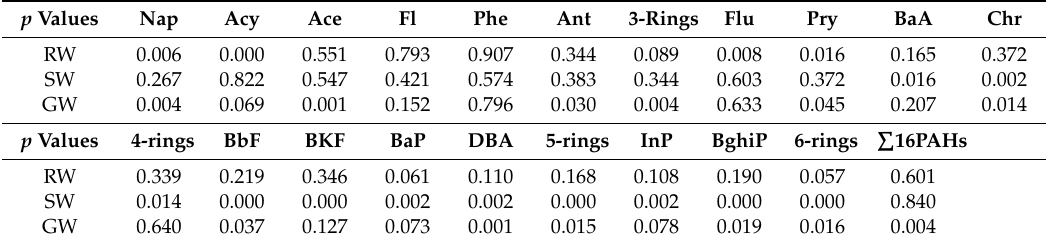
Table 2. p values of paired-samples t-test of PAHs concentration in reclaimed water, surface water and groundwater at same sampling sites in September 2013 and October